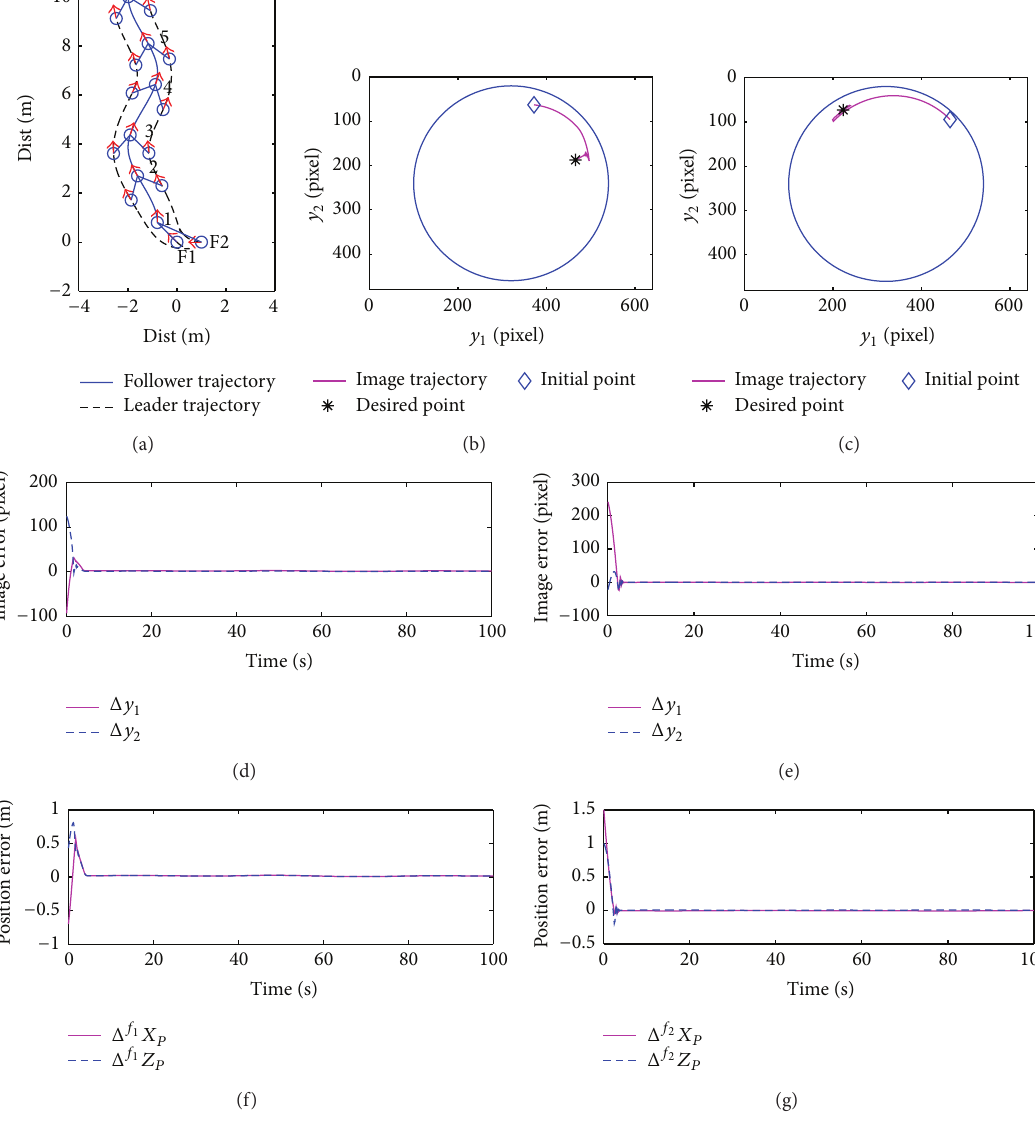
Figure 6: Arbitrary trajectory tracking results. (a) Trajectory in world frame. (b) Image trajectory of Follower1. (c) Image trajectory of Follower2. (d) Image error of Follower1. (e) Image error of Follower2. (f) Position error in frame Follower1. (g) Position error in frame